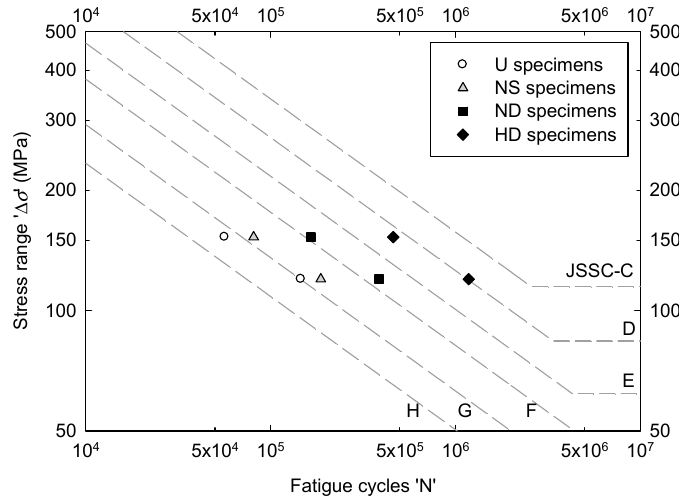
Figure 10. S - N plot for test results and JSSC categories.